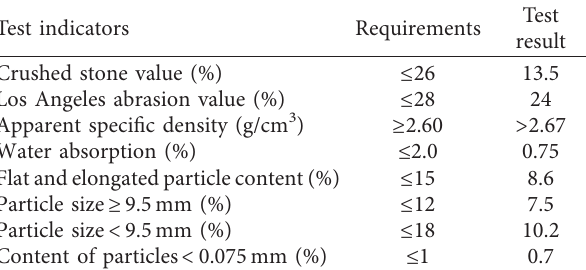
Figure 6: Design flowchart of DSAM. Table 1: Properties of coarse